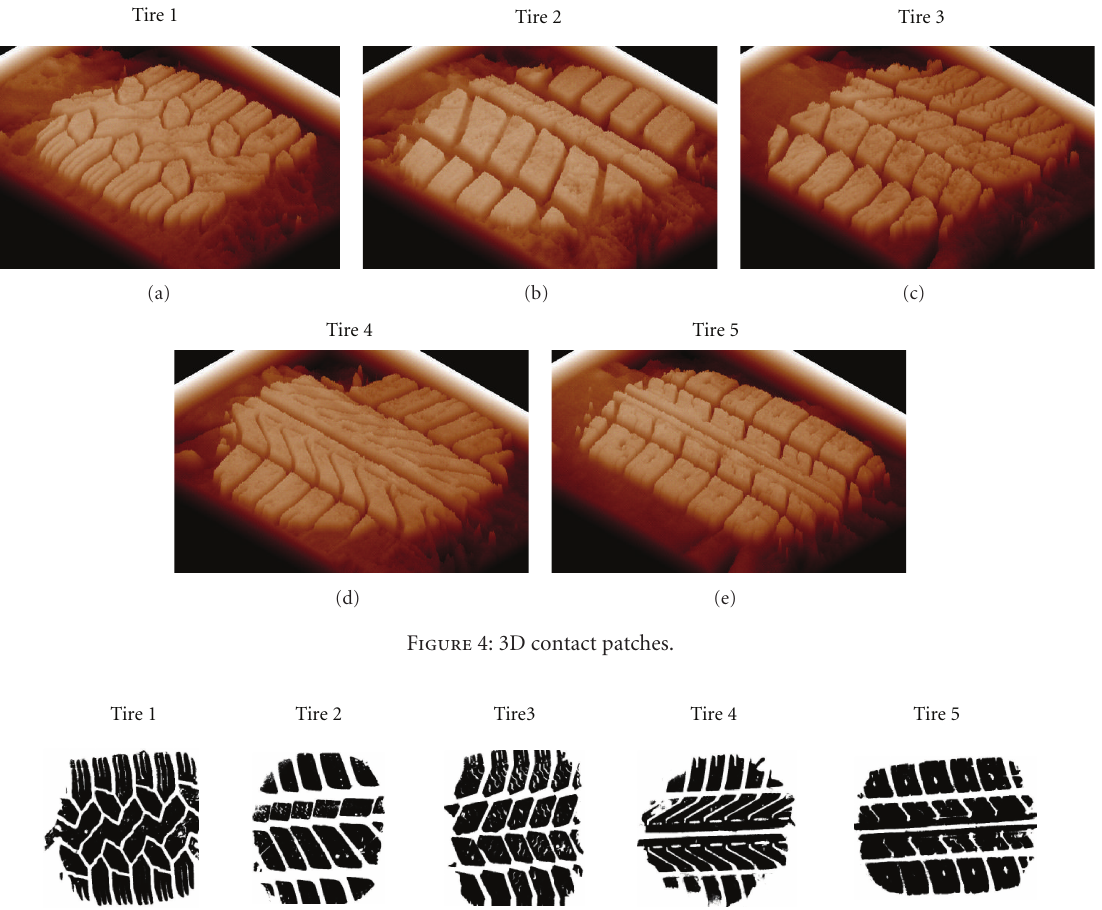
Figure 4: 3D contact patches.